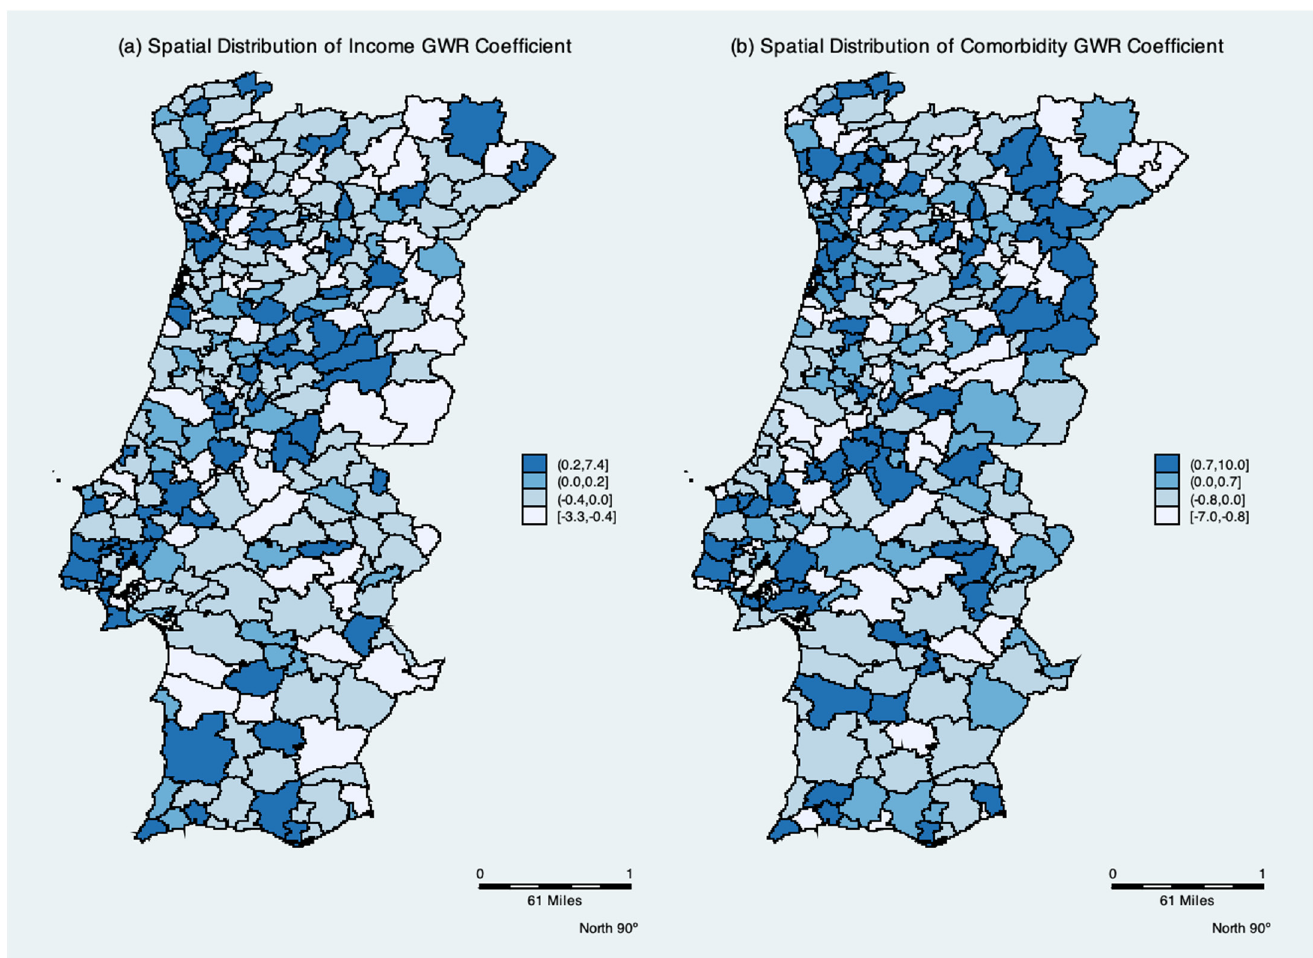
Figure 4. Spatial distribution of GWR parameter estimates. Subfigure ( a ) Spatial distribution of the income GWR parameter; ( b ) Spatial distribution of the comrbidity GWR parameter.